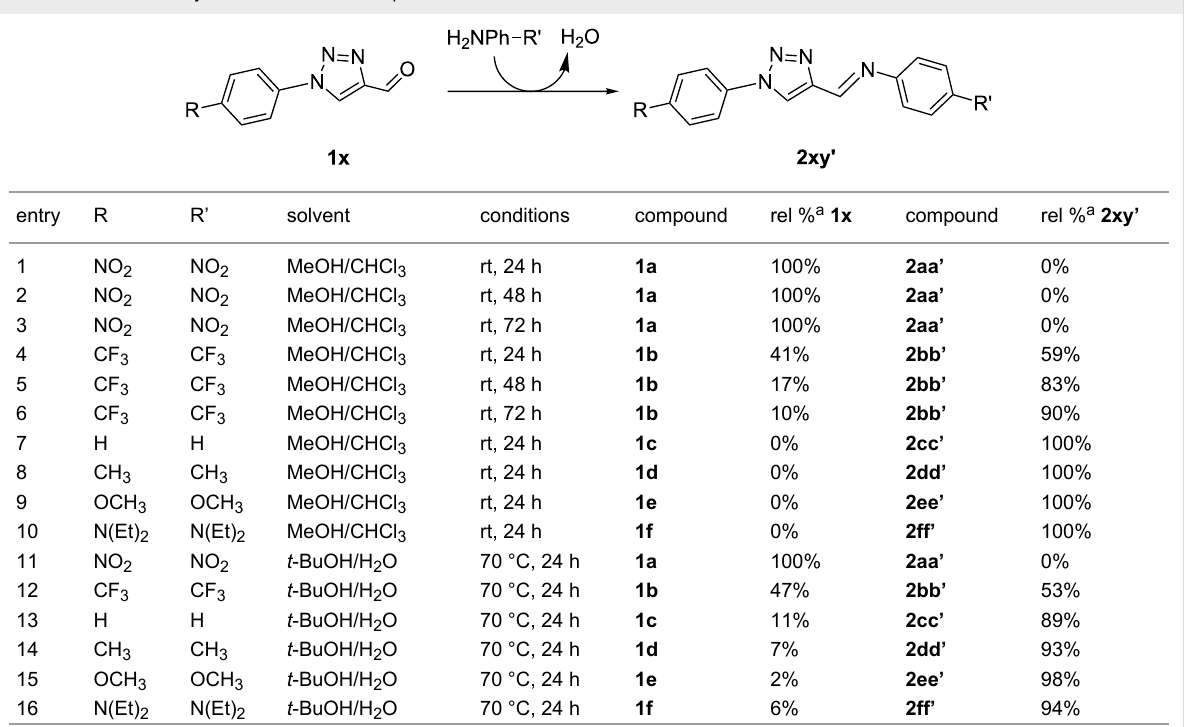
Figure 2, each of the three aromatic rings in this molecule’s fully conjugated π -system adopts a largely coplanar configura- tion. The dihedral angle between the 1-phenyl substituent and the triazole ring is 28°, the dihedral angle between the imino group and triazole ring is 0.5° and the dihedral angle between the phenyl and imino group is 32°. This structural detail supports the ability of the 1-triazolyl and imino arene units to communicate electronically through the intervening triazole ring via largely coplanar π -systems within this family of com- pounds.